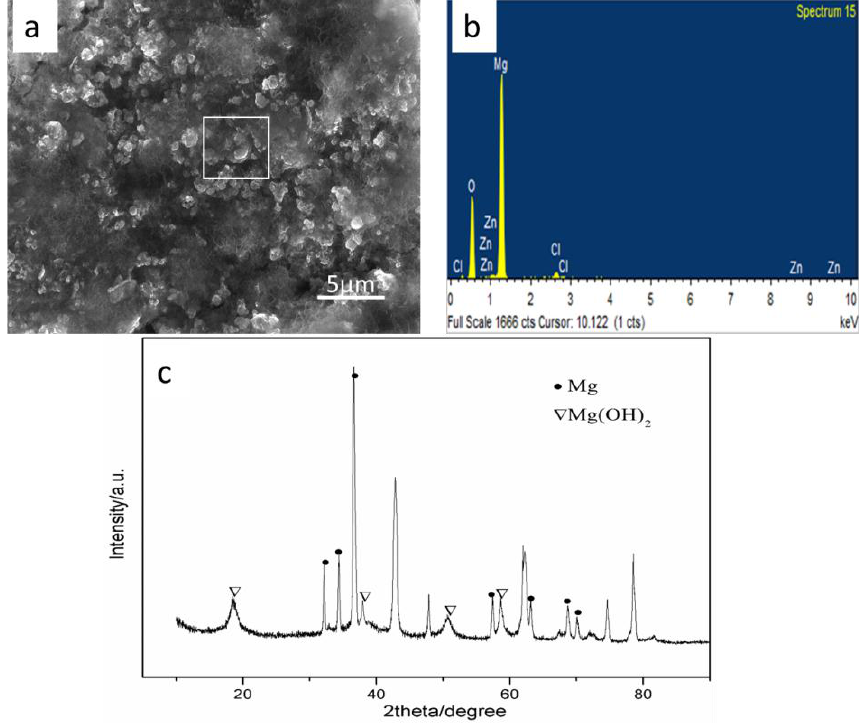
Figure 7. Corrosion products of the Mg-6Zn in SBF: ( a ) surface morphology; ( b ) composition analysis of EDS; ( c ) XRD identification.